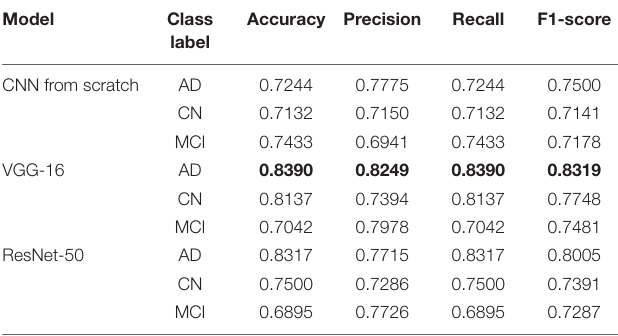
TABLE 4 | Testing accuracy, precision, recall, and F1-score for all class label.